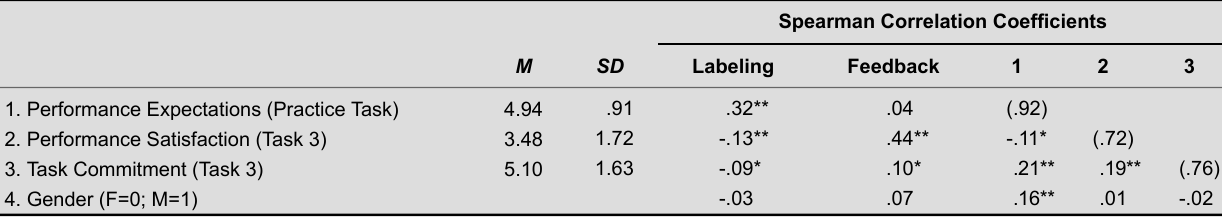
Means, Standard Deviations and Correlations Among